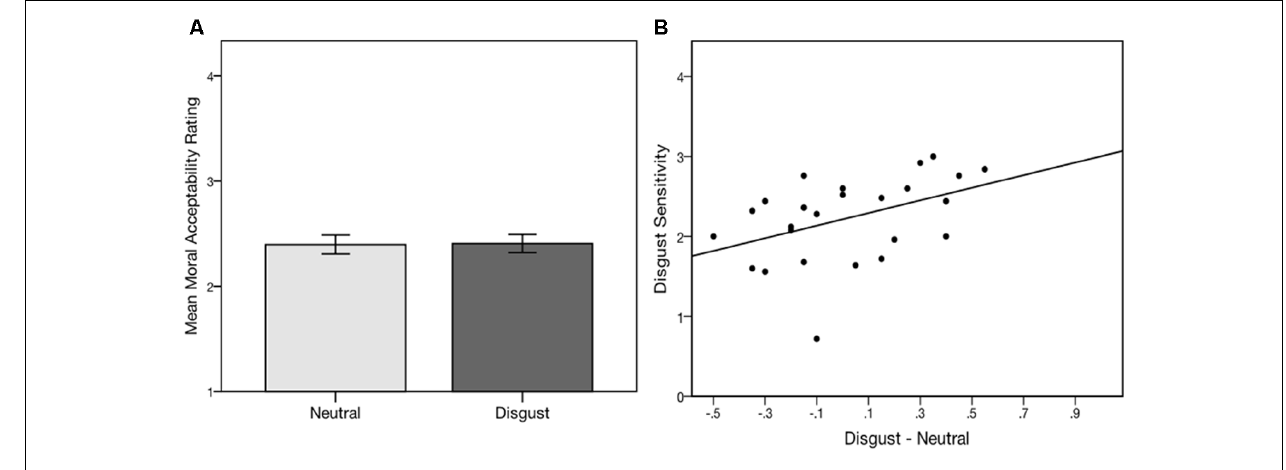
FIGURE 4 | (A) Conscious disgust priming followed by self-paced screen presentations of moral dilemmas had no main effect on moral judgments. Error bars represent + / − 1 SE. (B) The degree of influence of the conscious prime (as measured by the difference in mean response in the disgust and